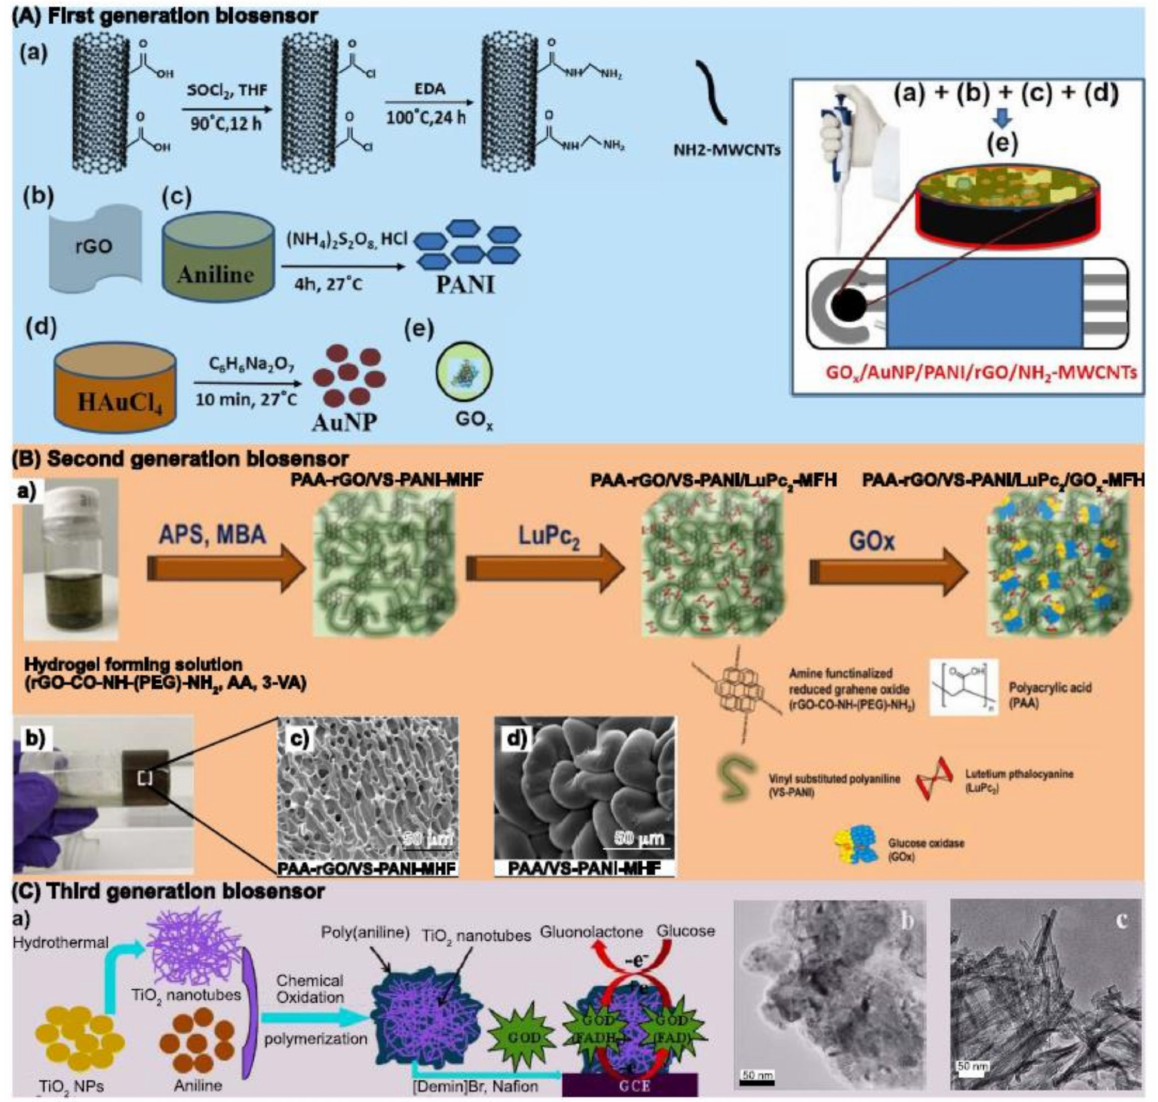
Figure 9. Applications of PAni in enzymatic biosensors: ( A ) Preparation of NH 2 -MWCNT/PAni/ rGO/AuNPs/GOx first generation biosensor: ( a ) synthesis of NH 2 -MWCNT, ( b ) rGO, ( c ) COP of PAni, ( d ) synthesis of AuNPs, ( e ) assembly of NH 2 -MWCNT/Pani/rGO/AuNPs for GOx immobilization; ( B ) the assembly of PAA/rGO/VS-PAni/LuPc 2 /GOx/MHF for second generation biosensor ( a ), a view of the obtained MFH ( b ) along with SEM images of the morphology of PAA/rGO/VS-Pani/MHF ( c ) and MHF morphology without rGO ( d ); ( C ) synthesis of PAni/TiO 2 NT composite for third generation biosensor ( a ), and SEM images of PAni ( b ) and TiO 2 NT ( c ). Figures reproduced with permission